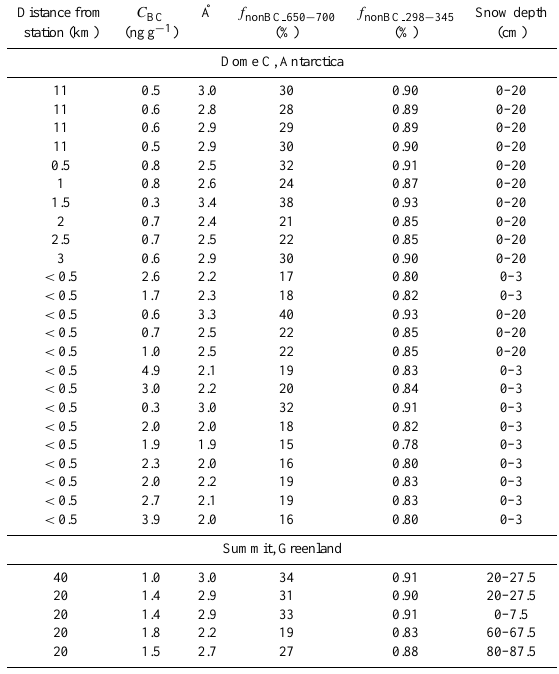
Table B1. Description of individual snow samples collected near Dome C, Antarctica, in January 2004 and Summit, Greenland, in June 2007. The black carbon concentration ( C BC ), the Angstrom exponent ( ˚A), the fraction of nonBC ( f nonBC ) absorption in the λ =650–700nm and λ =298–345nm ranges, and the snow depths over which these samples were collected are provided. Distance